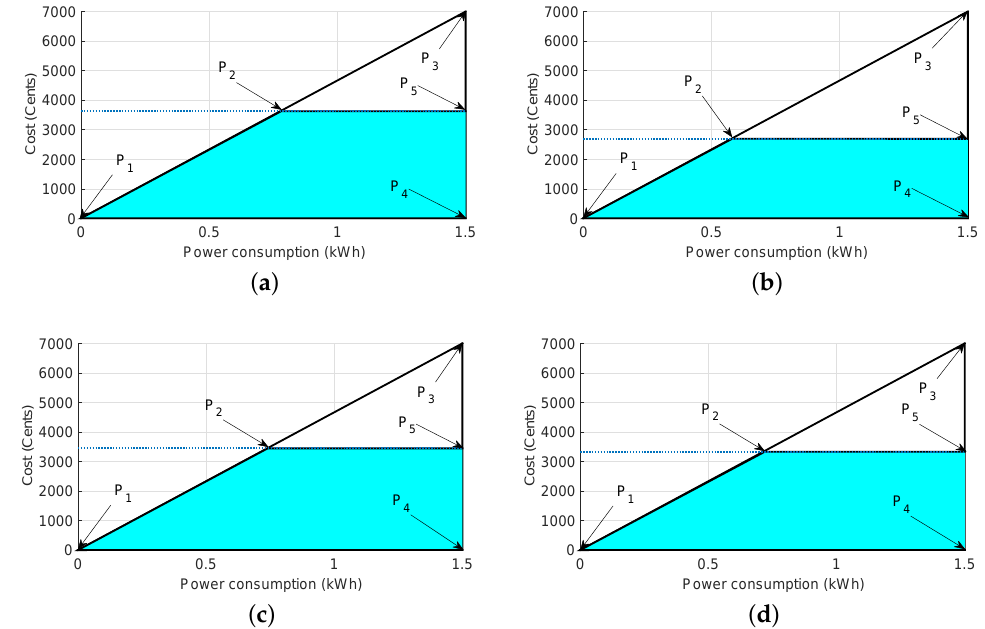
Figure 17. Feasible regions for a single home using real time pricing. ( a ) Operational time interval of 1 min; ( b ) Operational time interval of 20 min; ( c ) Operational time interval of 30 min; ( d ) Operational time interval of 60